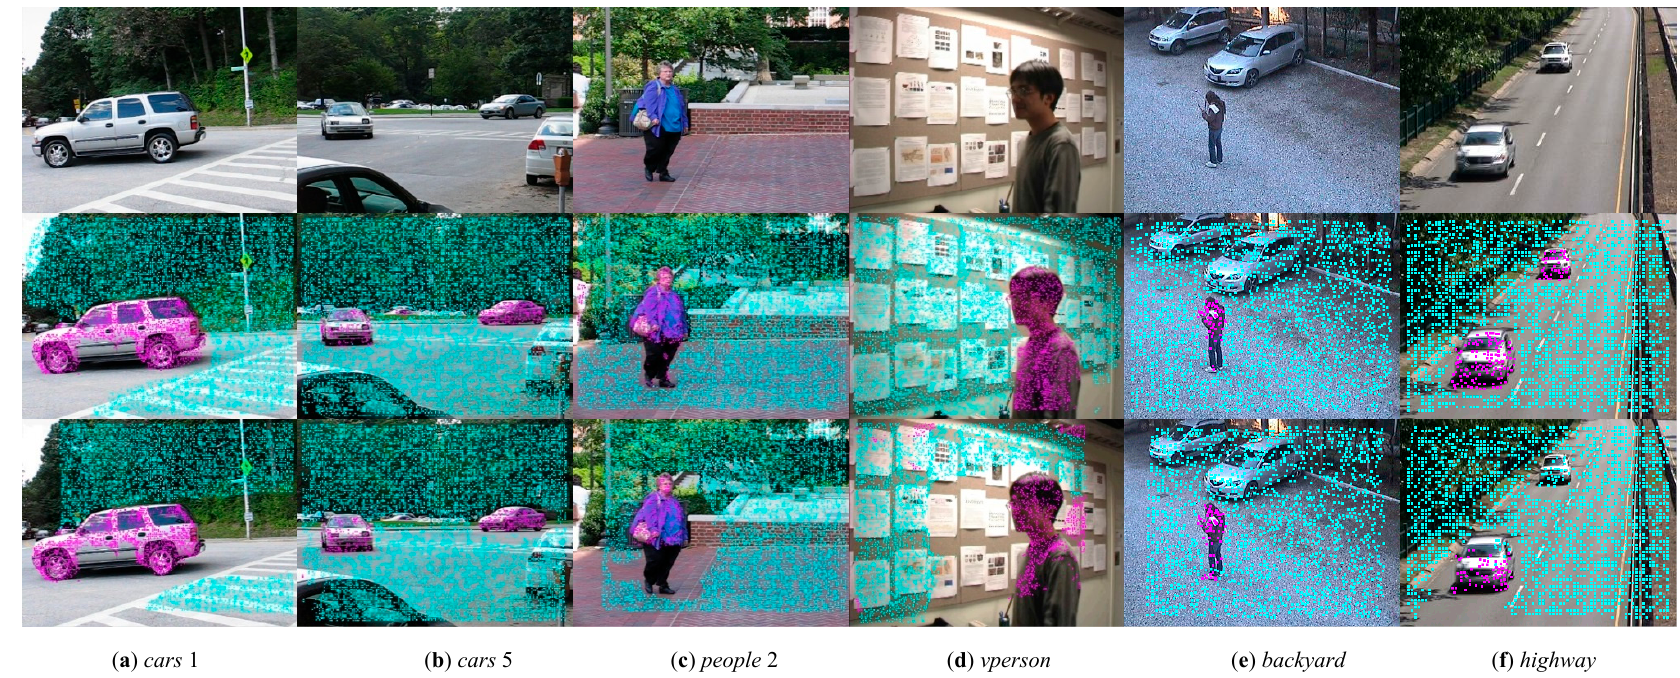
Figure 4. Trajectory classification results on the cars 1 (column 1), cars 5 (column 2), people 2 (column 3), vperson (column 4), backyard (column 5), and highway (column 6) sequences using our method (row 2) and Sheikh et al. [22] (row 3). For visualization purposes, the foreground and background trajectories are shown by the purple, and blue colors, respectively.